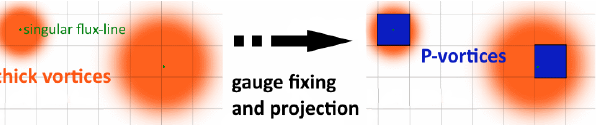
Figure 2. Vortex detection as a best-fit procedure of P-Vortices to thick vortices shown in a two- dimensional slice through a four-dimensional lattice.